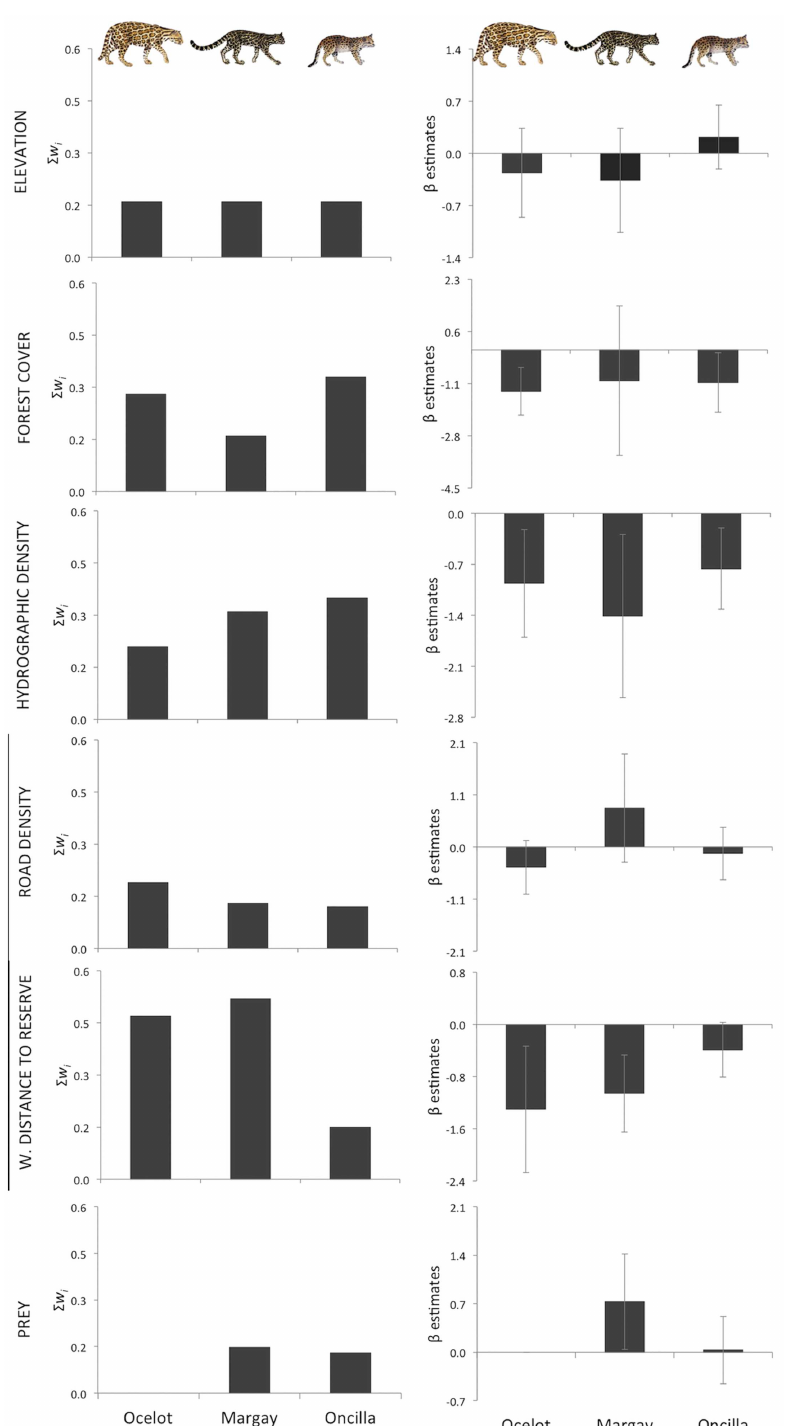
Fig 3. Covariates effect on the occupancy of Neotropical spotted cats. Influenceof geomorphometry, environmental, and anthropogeniccovariateson the occupancy of spotted cats in a large Atlantic Forest remnant, showingthe sum of w i (which indicatesthe relative importance of covariates)and the associated beta estimates with standard error estimated from the single-season single-species models.